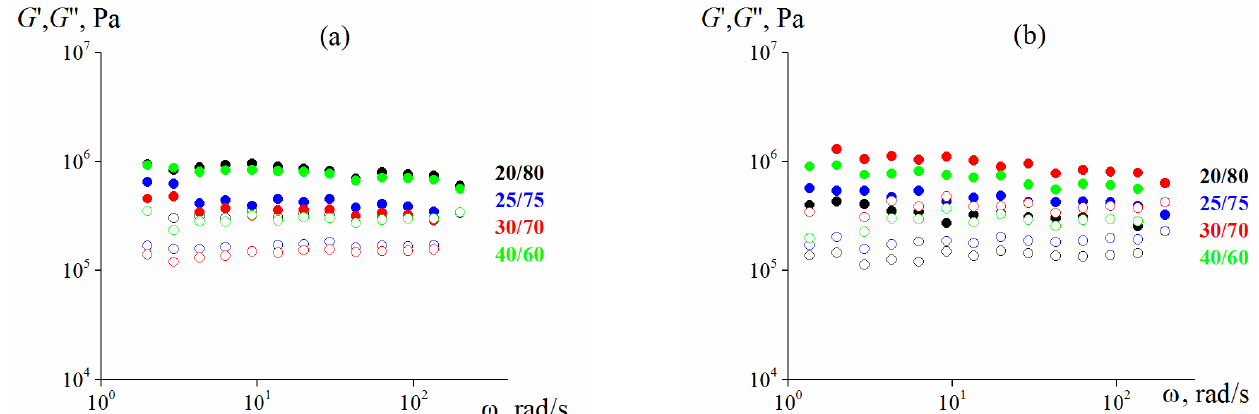
Figure 4. Frequency dependences (at γ = 0.001) of the storage modulus for 75%, ( a ) and 80% suspensions ( b ) with different larger and smaller particles ratios (the storage modulus is marked by dark symbols, the loss modulus—by light ones). In both cases λ = 2.4.